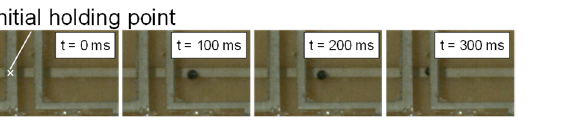
Figure 13. Transfer from an initial holding point to the adjacent cross point (the upper electrode of the initial point is floating).